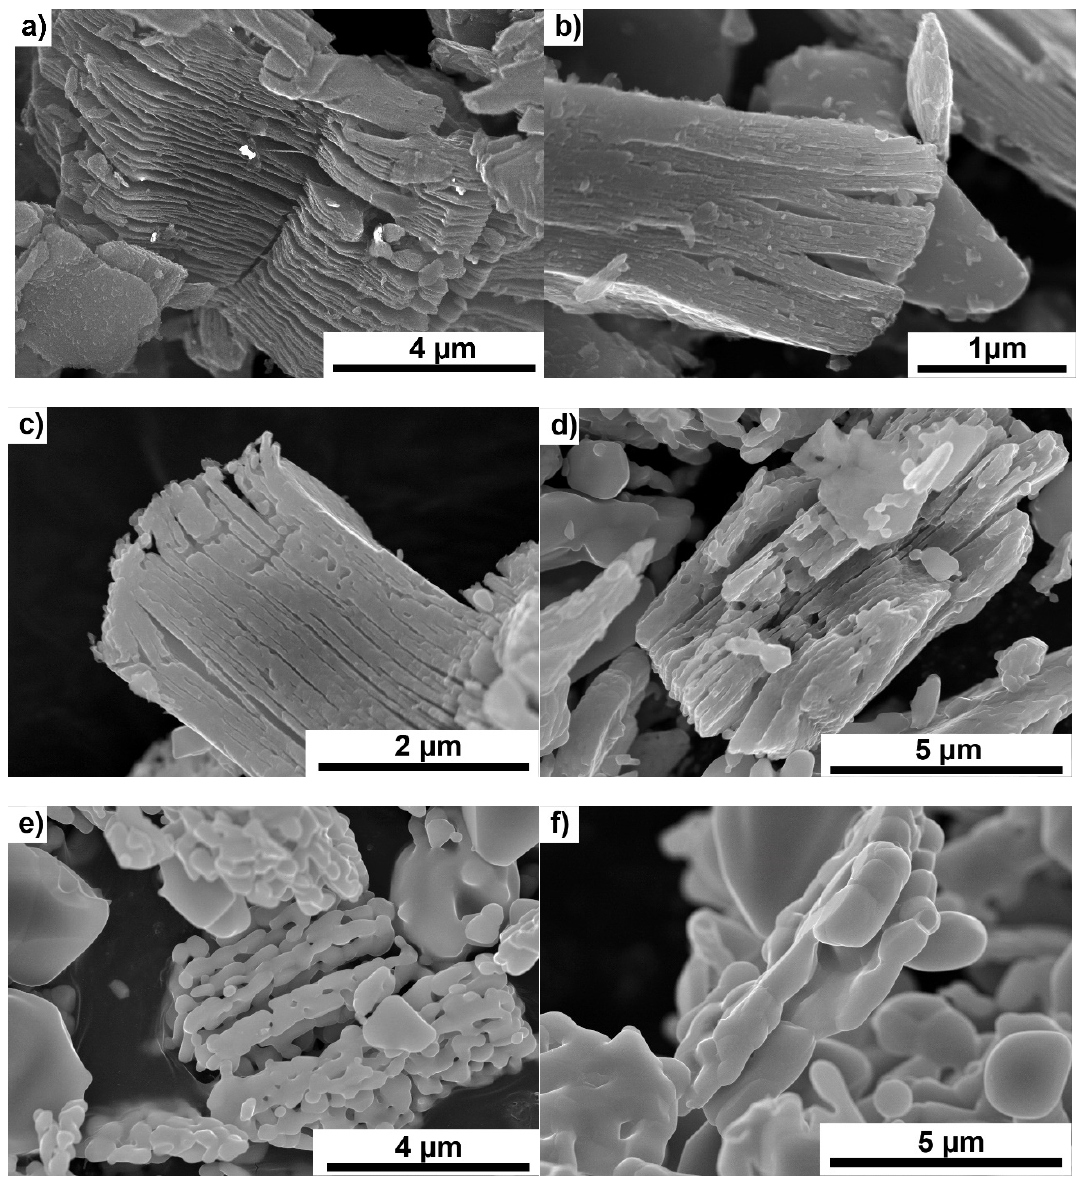
Figure 1. Morphology of Ti 3 C 2 MXene powders; starting powder ( a ) powders annealed in argon at temperatures of ( b ) 1000 °C, ( c ) 1200 °C, ( d ) 1400 °C, ( e ) 1600 °C and ( f ) 1800 °C .